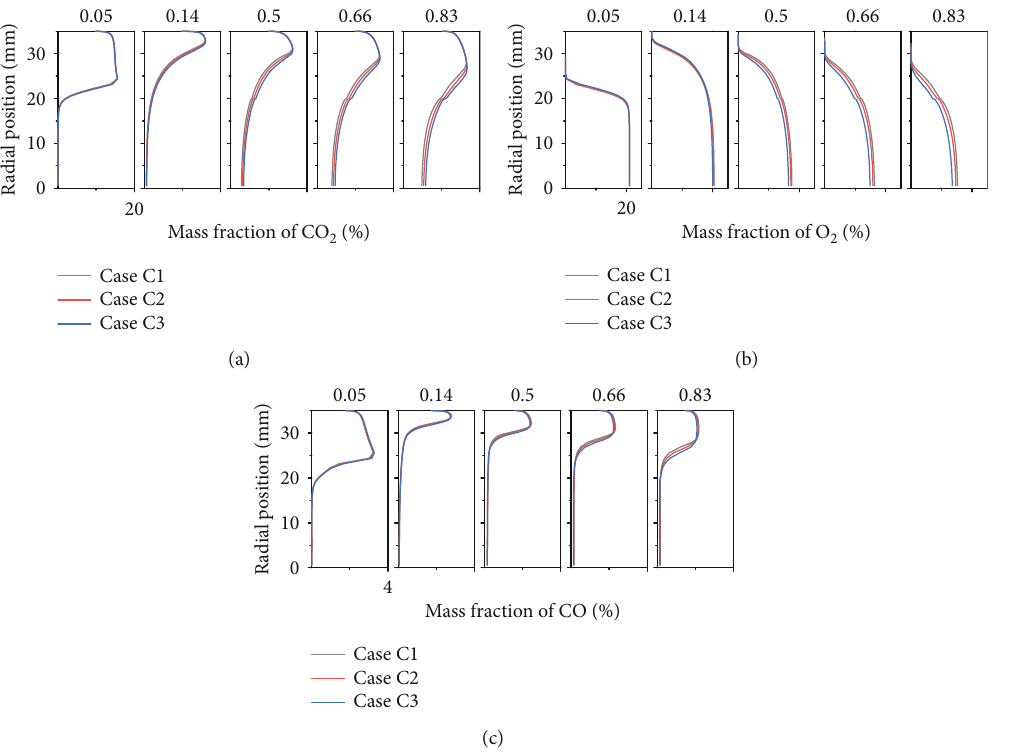
Figure 19: Radial pro fi les of the mass fraction of CO